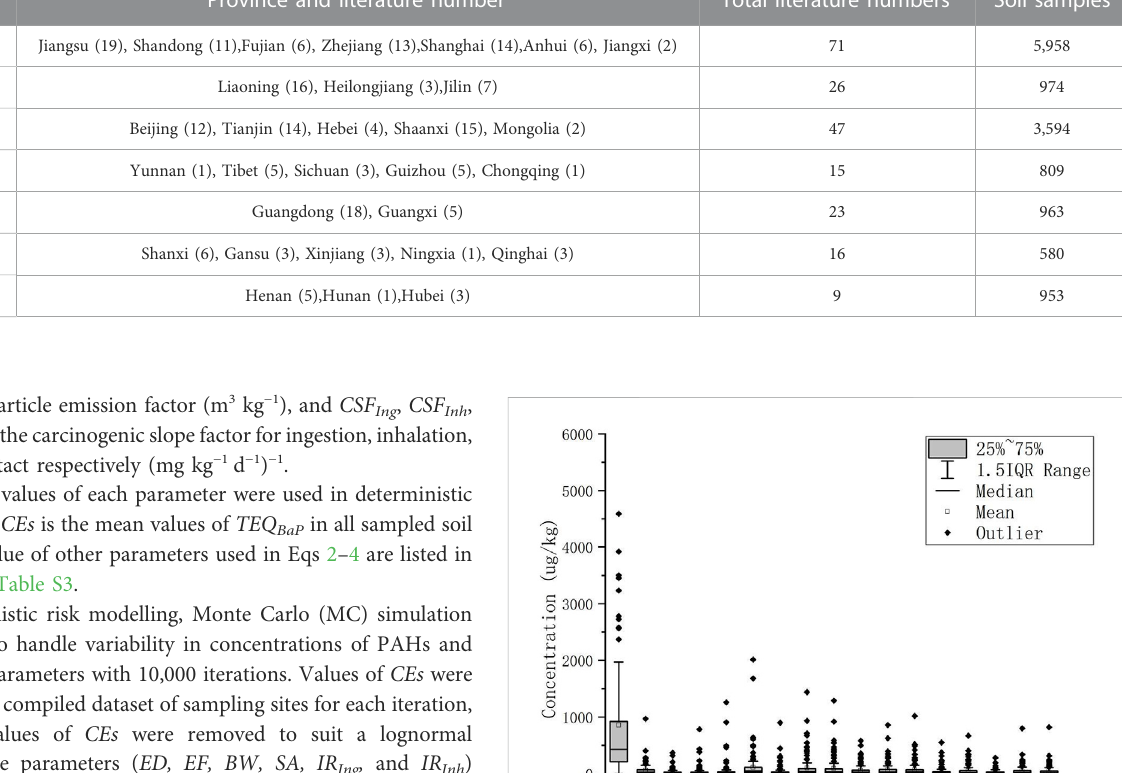
TABLE 1 Distribution of collected literature and soil samples of PAHs in China ’ s surface soils. Region